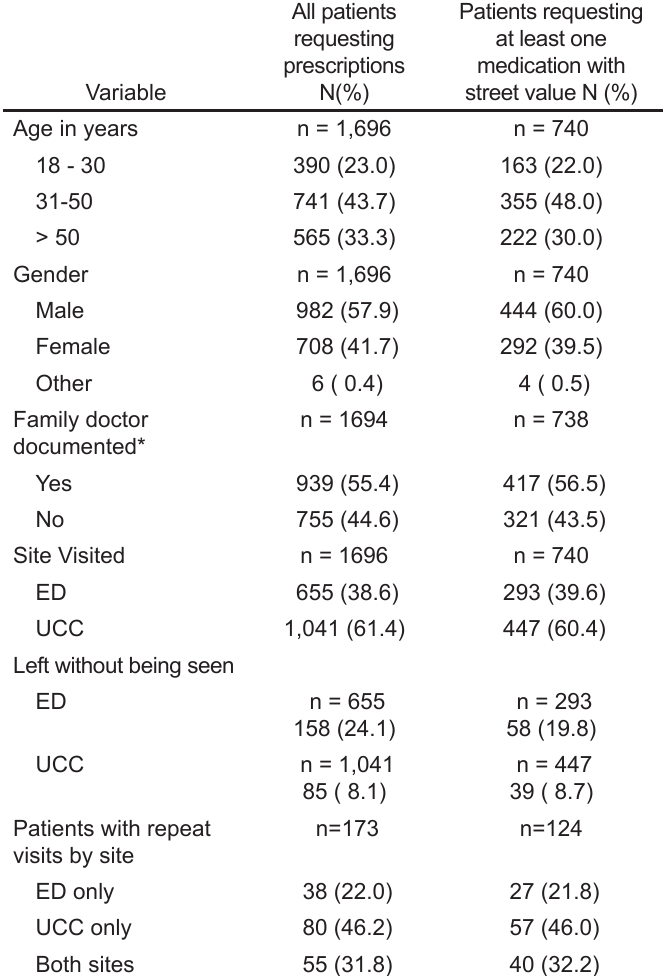
Table 1. Patient and response